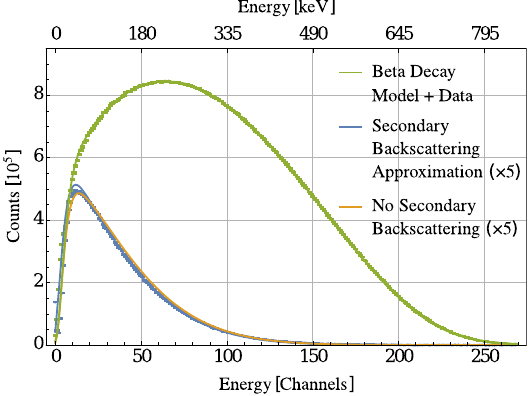
Figure 2. A simulated backscattering spectrum (scaled by a factor of 5) is compared to data from neutron decay measurements with P ERKEO III. If considering backscattering of backscattered electrons – denoted as secondary backscattering – simulation (solid lines) and data agree well. The norm is obtained from the complete beta decay spectrum, all detector parameters are fixed by measurements with calibration